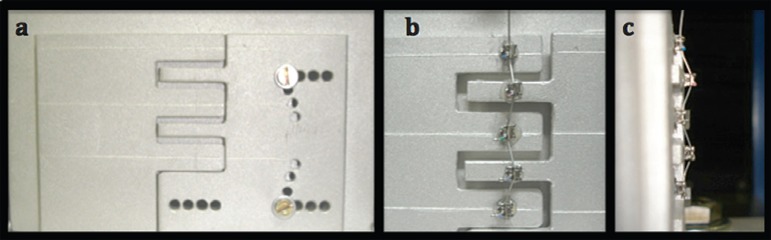
A) Prototype especially designed for the present study. B) Vertical
malalignment. C) Horizontal malalignment.